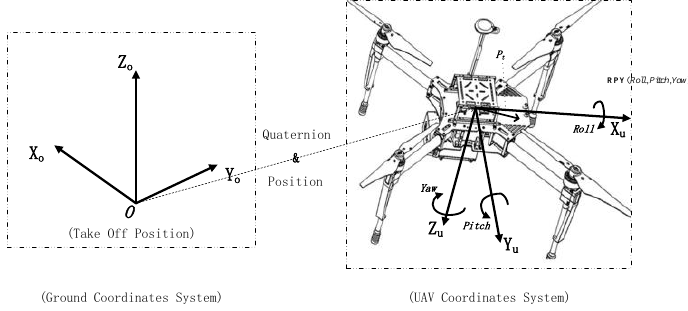
Figure 3. The UAV coordinate system and ground coordinate system are constructed separately, and the pose and velocity of the moving platform and UAV are obtained through coordinates.